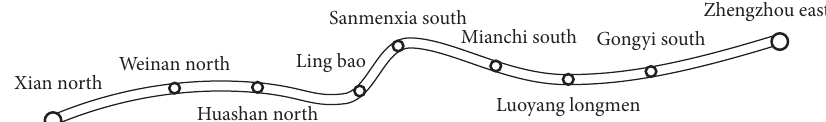
Figure 3: Zhengzhou-Xi’an high-speed railway.